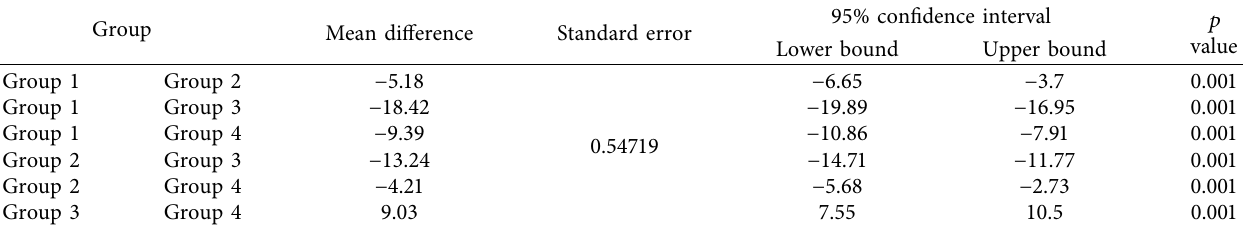
95% confidence interval